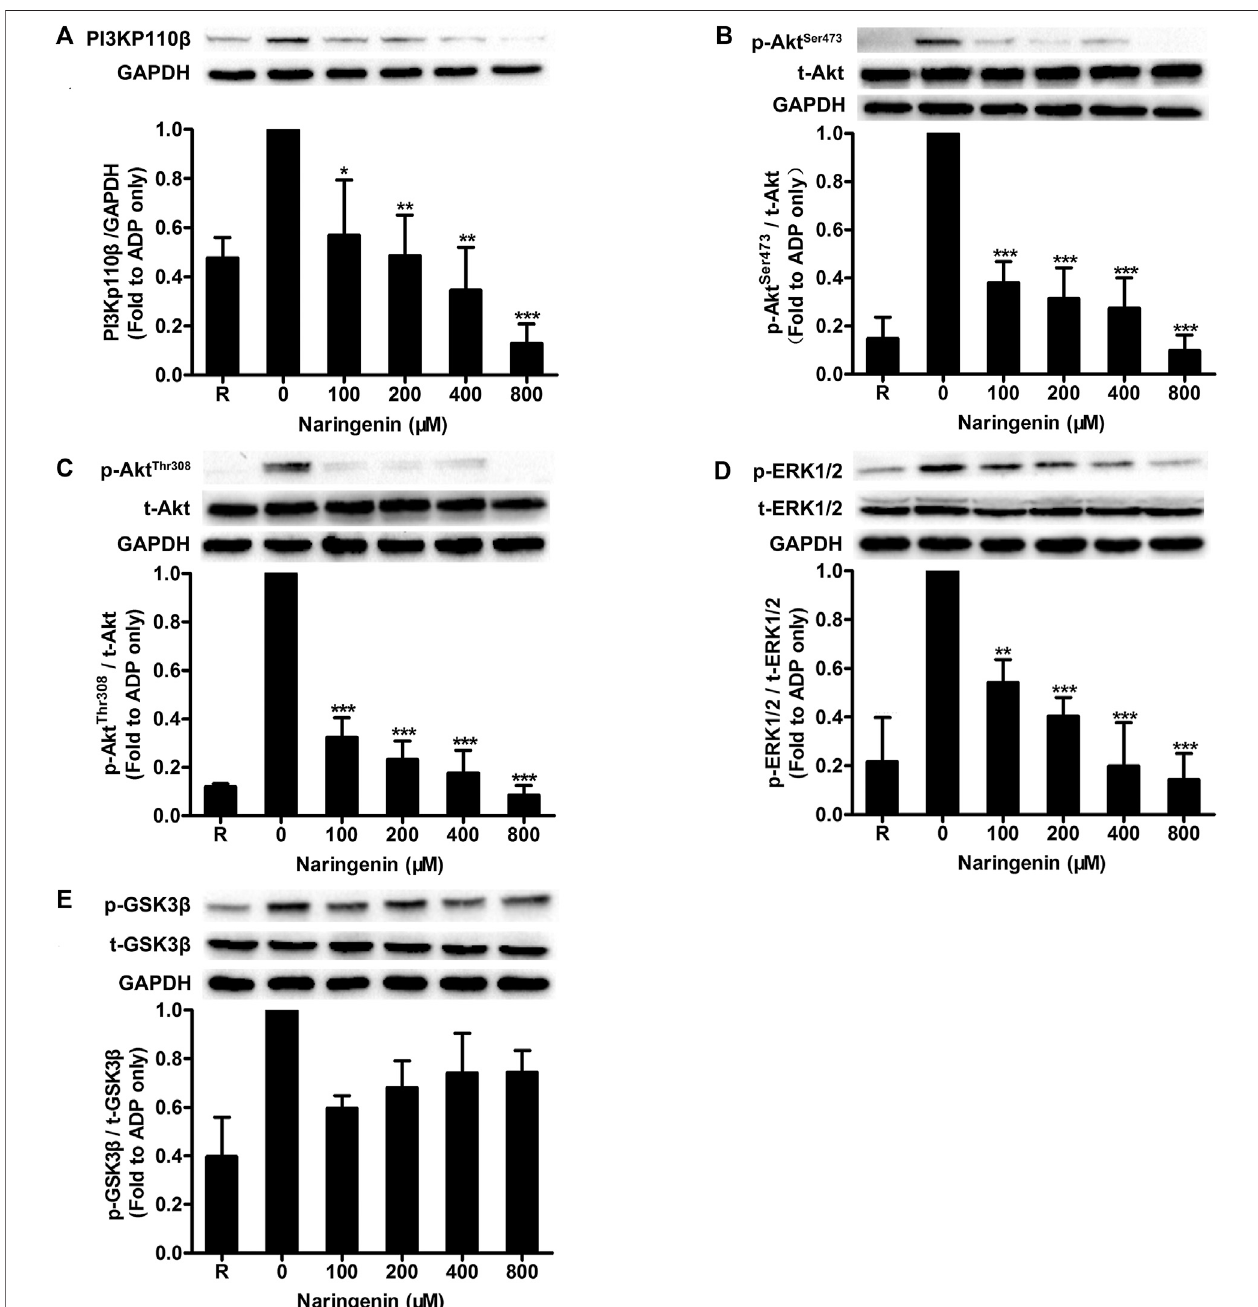
FIGURE 4 | Naringenin inhibits PI3K-mediated signaling in ADP-induced platelets. Washed rat platelets were preincubated without or with naringenin at 37 ° C for 5 min, and then stimulated with ADP (10 μ mol/L) under stirring for 5 min. Platelet proteins were then extracted and analyzed by immunoblotting using PI3Kp110 β antibody (A) and phospho-speci fi c antibodies such as Akt Ser473 (B) , Akt Thr308 (C) , ERK1/2 Thr202/Tyr204 (D) and GSK3 β Ser9 (E) . Total level of GAPDH was measured on each sample as a loading control. The blots shown are representative of three separate experiments. The relative protein expression levels were quanti fi ed by ImageJ1.47vsoftware. Thelevelofrelativeproteinexpression obtainedwithvehiclecontrol(0 μ M)wastakenas1.Rrepresentsthelevelofrelative proteinexpression in resting platelets. Data are expressed as means ± SD ( n (cid:2) 3). * p < 0.05, ** p < 0.01, *** p < 0.001 compared with the vehicle control group.